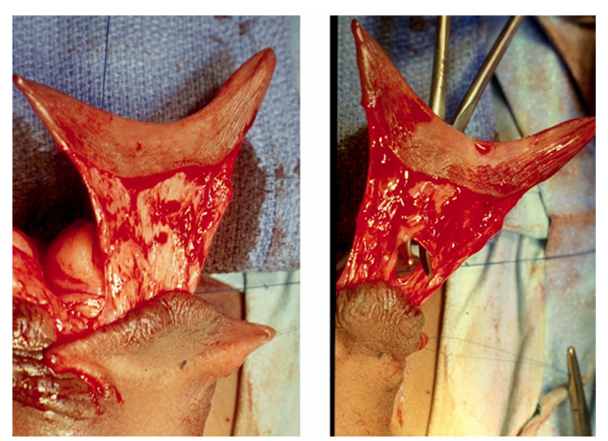
FIGURE 2 |The left panel shows the dissection of the pedicle for the TPF. It is important that the dissection plane is close to the dorsal skin. Use of mono or bipolar coagulation should be strictly avoided.The right panel illustrates the creation of a buttonhole at the base of the pedicle used to transpose the flap vertically.The buttonhole is created bluntly and enlarged in a longitudinal direction to avoid vascular injury.